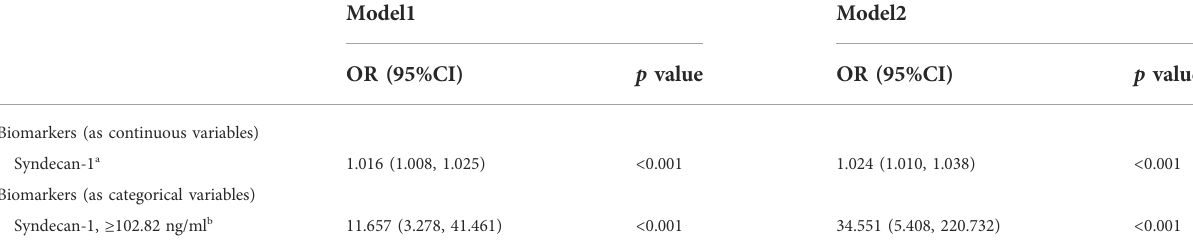
TABLE 2 Syndecan-1 alone and in combination predicted the prognosis of AIS patients treated with intravenous thrombolysis.